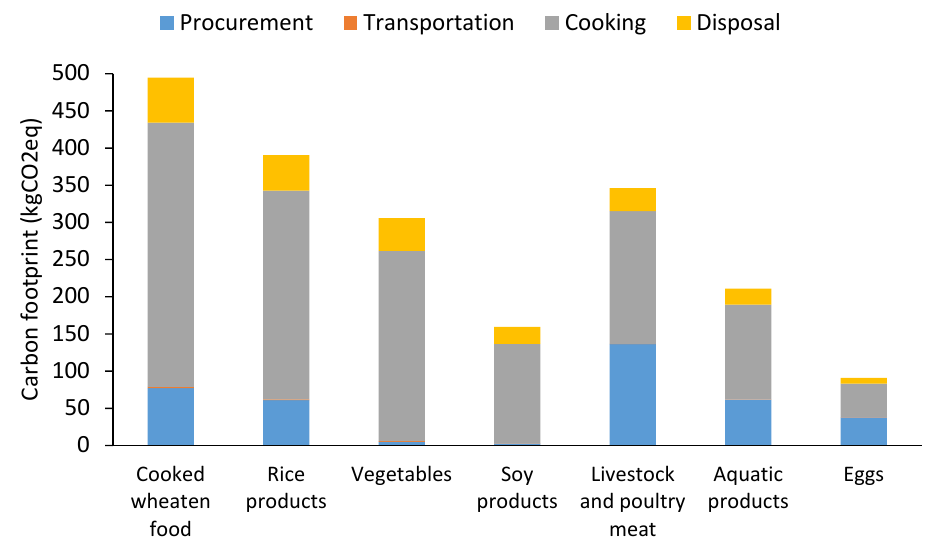
Figure 2. Distribution of carbon footprint of food waste in university canteens.